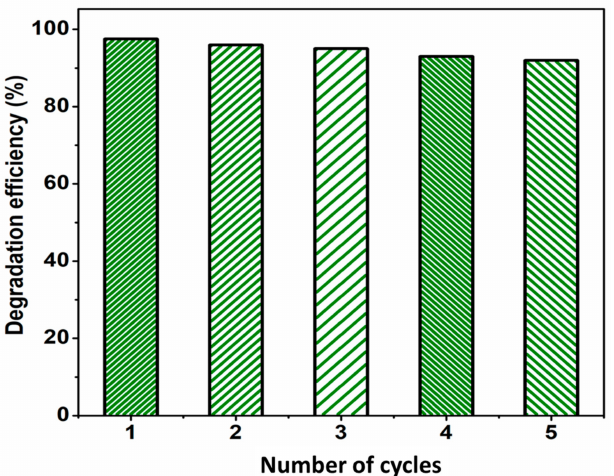
Figure 9. Stability of sample ZnO/graphene nanocomposite (S1) for photocatalytic degradation of MB dye for 5